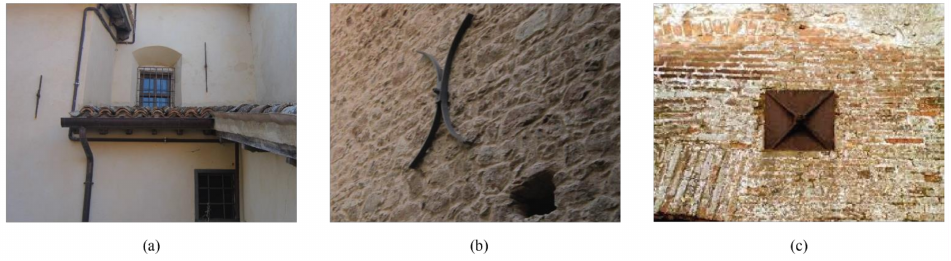
Figure 6. Different anchorages of tie rods for masonry buildings: low ( a ), medium ( b ) and high ( c )